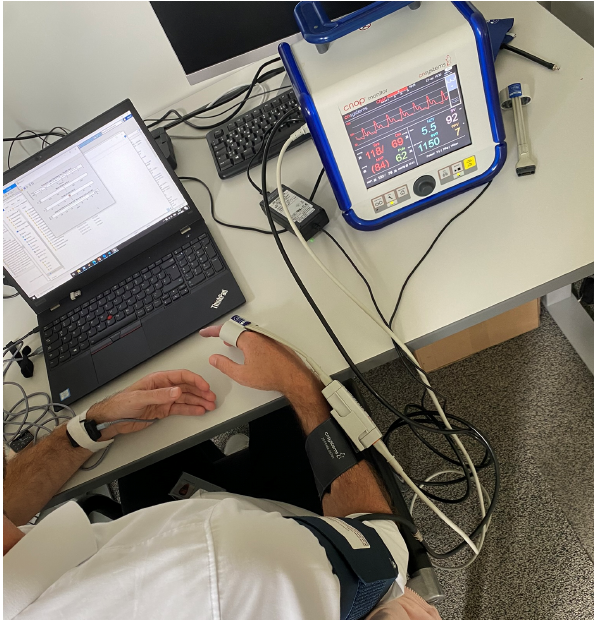
Figure 11. Data campaign